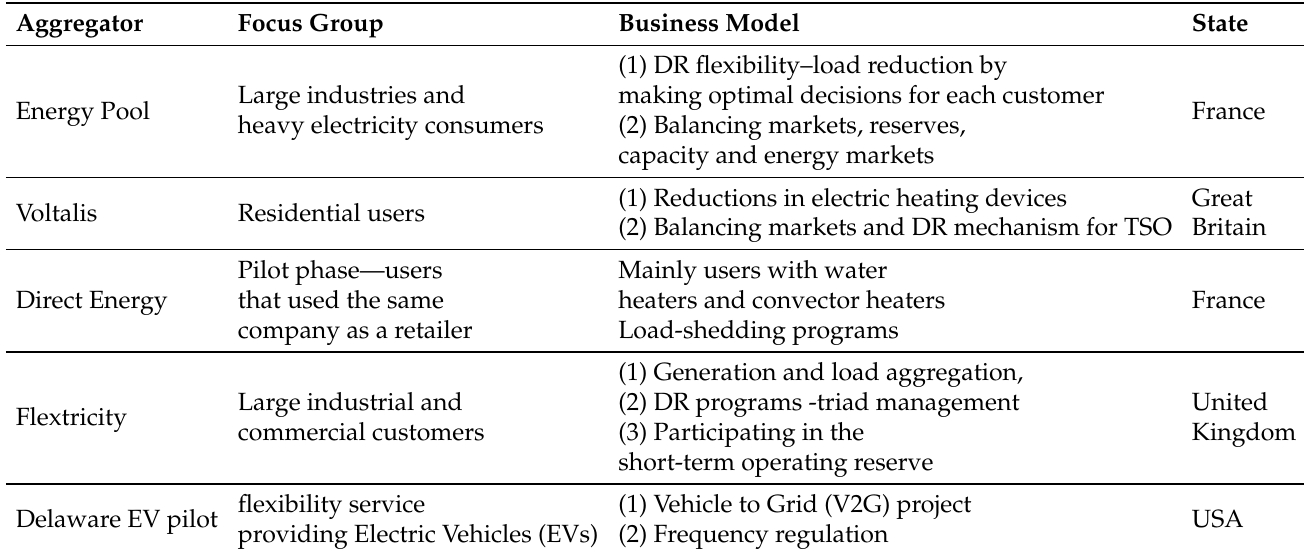
Table 1. Some of the existing